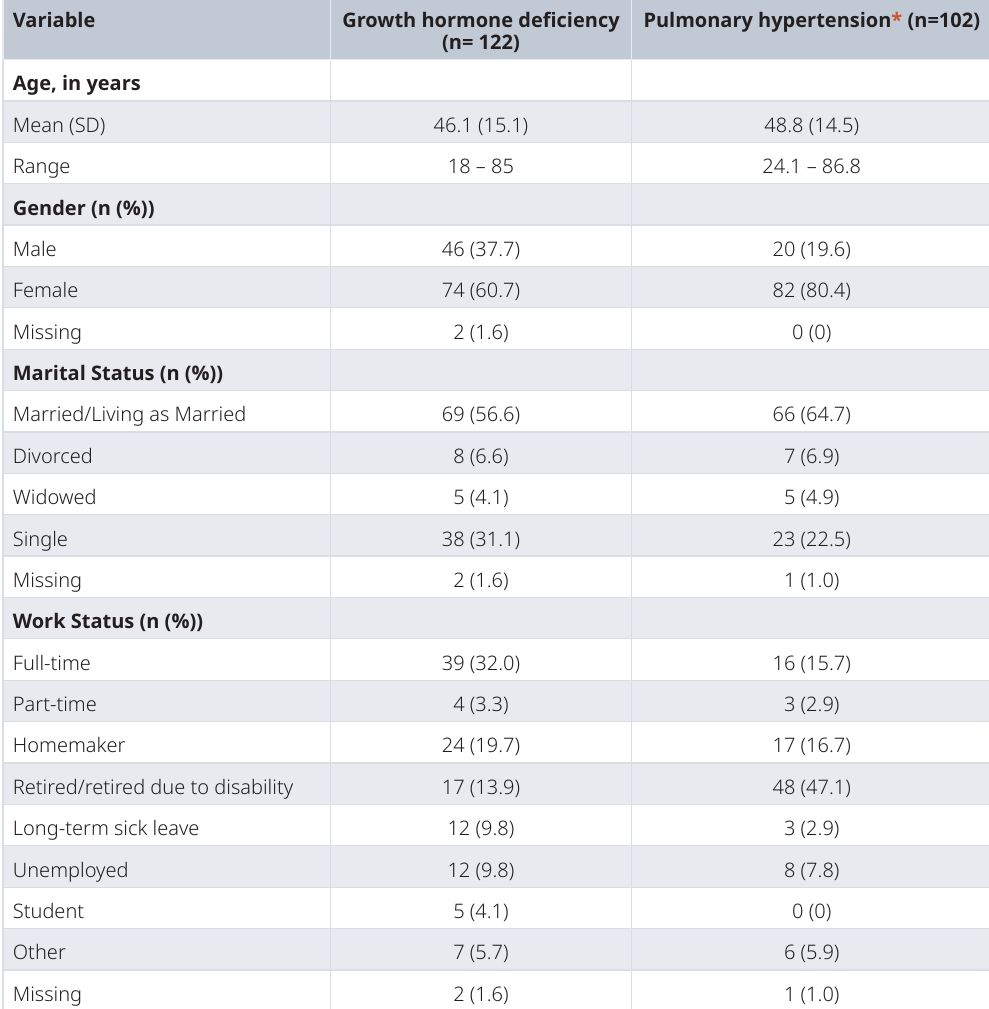
Table 1. Demographic details of adult growth hormone deficiency and pulmonary hypertension